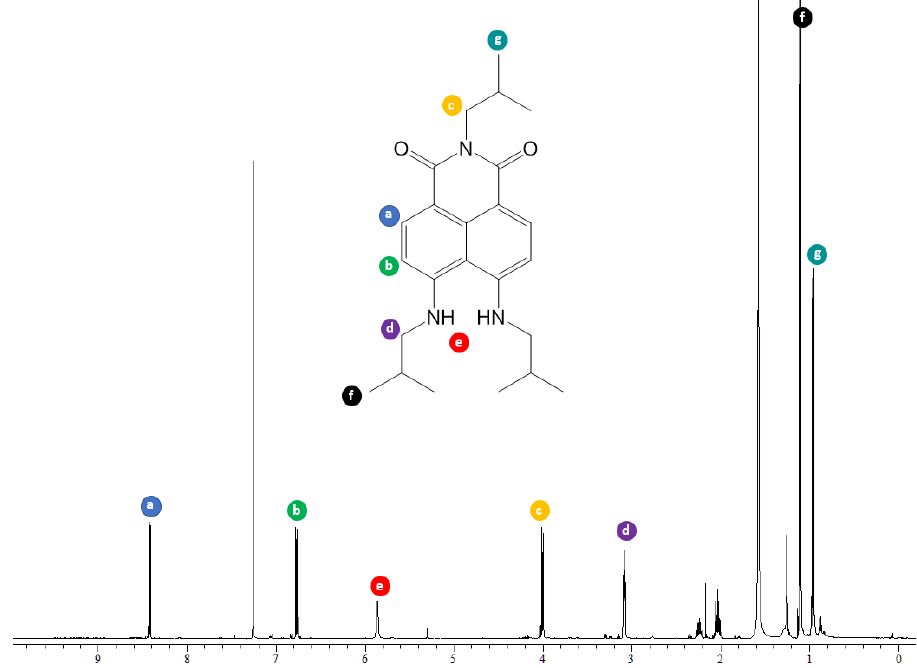
Figure 2. 1 H NMR spectrum of 2 in CDCl 3 and molecular structure, with correlation between signals and protons .